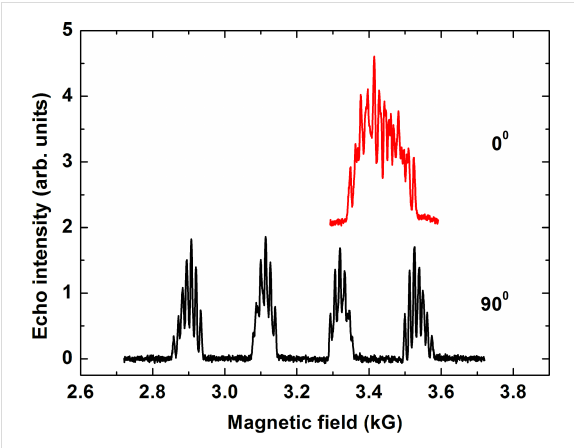
Figure 2: Echo detected ESR spectra of P1 at a frequency ν = 9.85 GHz (X-band) and at T = 20 K for the magnetic field oriented normal (90°) and parallel (0°) to the molecular